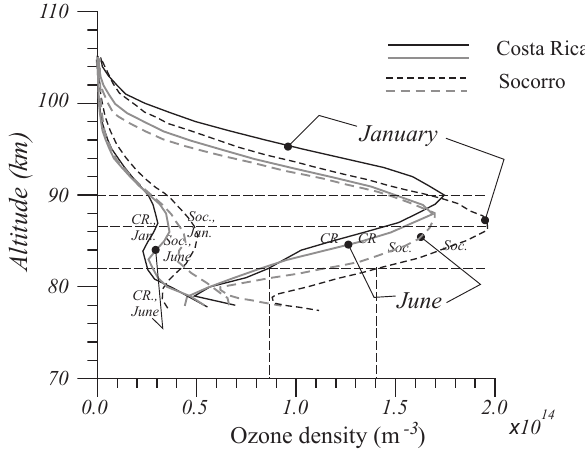
Figure 9. Height profiles of ozone density for Costa Rica and So- corro for January and June, from the WACCM model. Values should only be considered as representative of the real atmosphere to within a factor of typically 2, but shapes of profiles are generally consid- ered representative of reality. Both daytime and night-time values are shown, with the daytime values being much smaller and ap- pearing to the left. Peak heights of ozone density for January night- time at the two sites are marked as horizontal broken lines, as is the 82km altitude level. The increased height of the January peak at Costa Rica relative to Socorro is